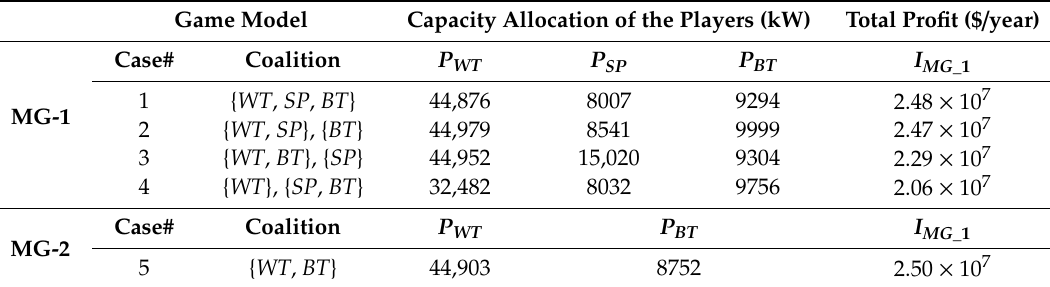
Table 2. Nash equilibrium results for the networked